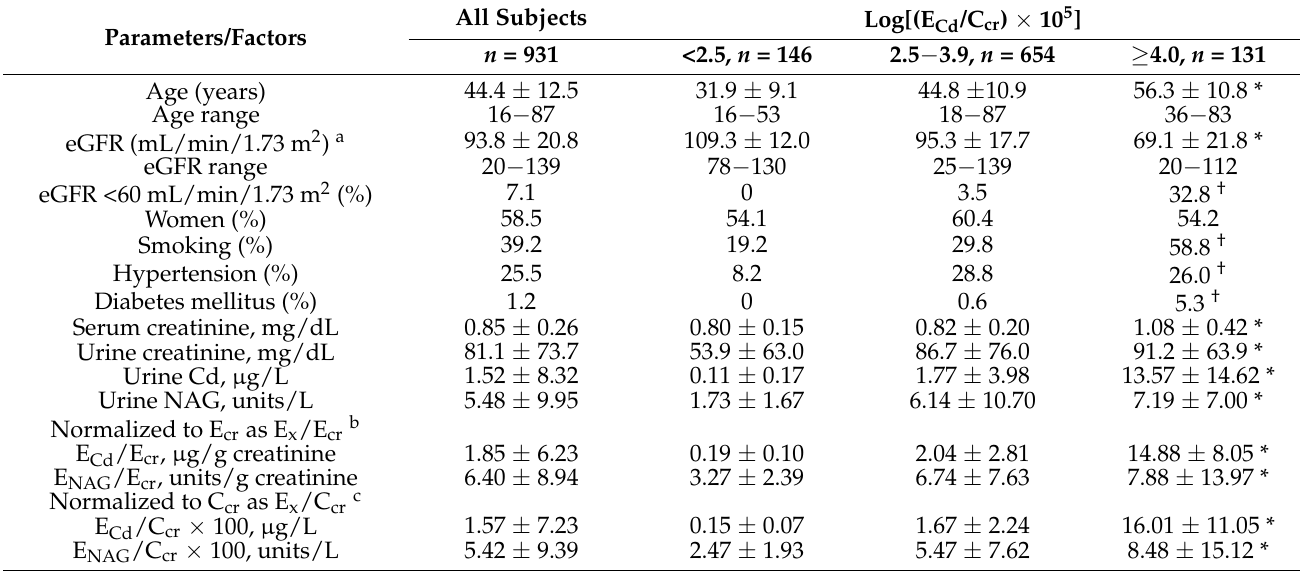
Table 1. Study subjects grouped by urinary cadmium excretion rates normalized to creatinine clearance. Parameters/Factors